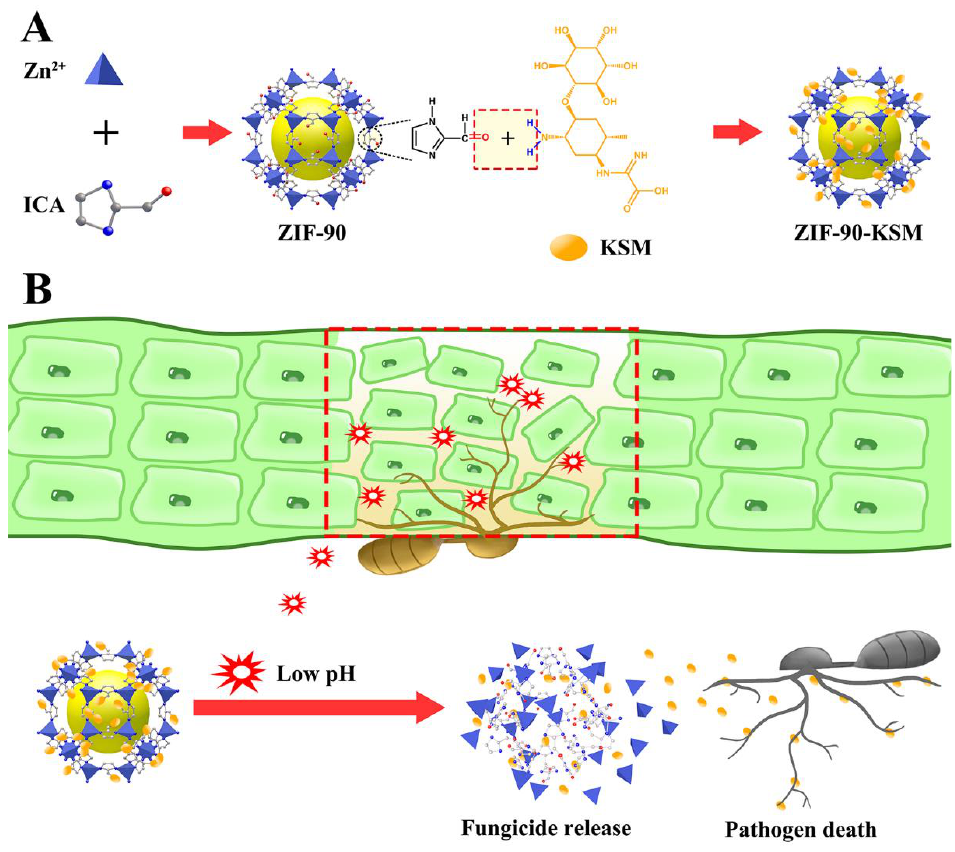
Figure 1. The mechanism for preparation of the ZIF-90-KSM ( A ). The triggered-release mechanism of KSM from ZIF-90-KSM ( B ).